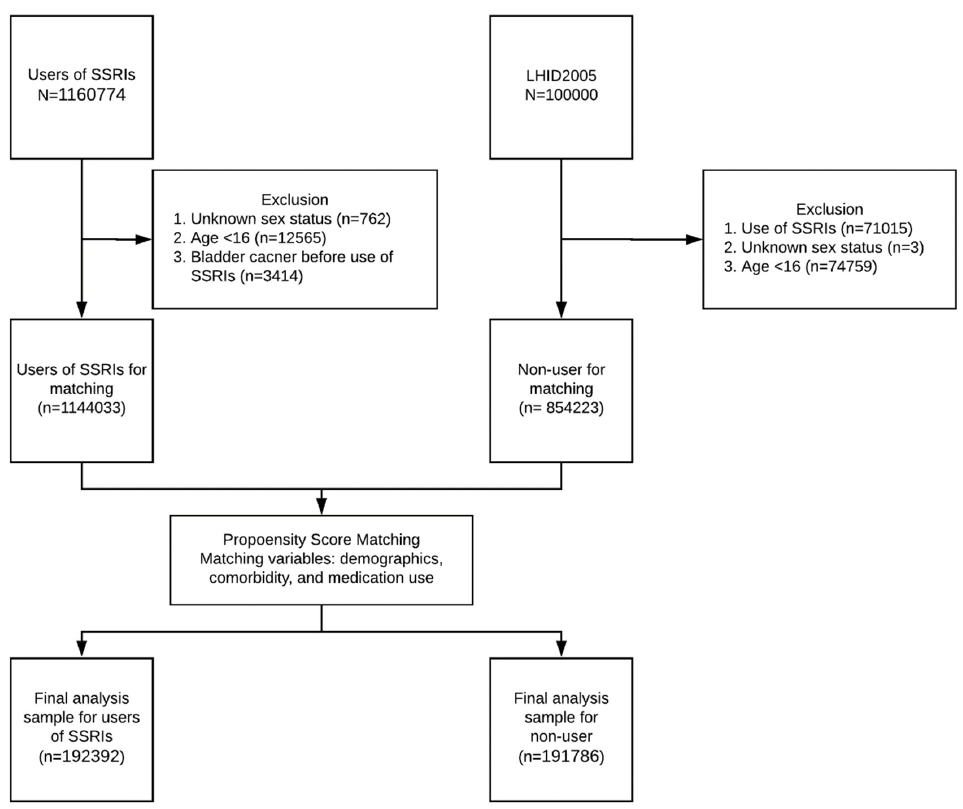
Figure 2. Flow chart of data collection in this study. Participants were followed from the index date, until first diagnosis of bladder cancer, death, or the end of 2013.